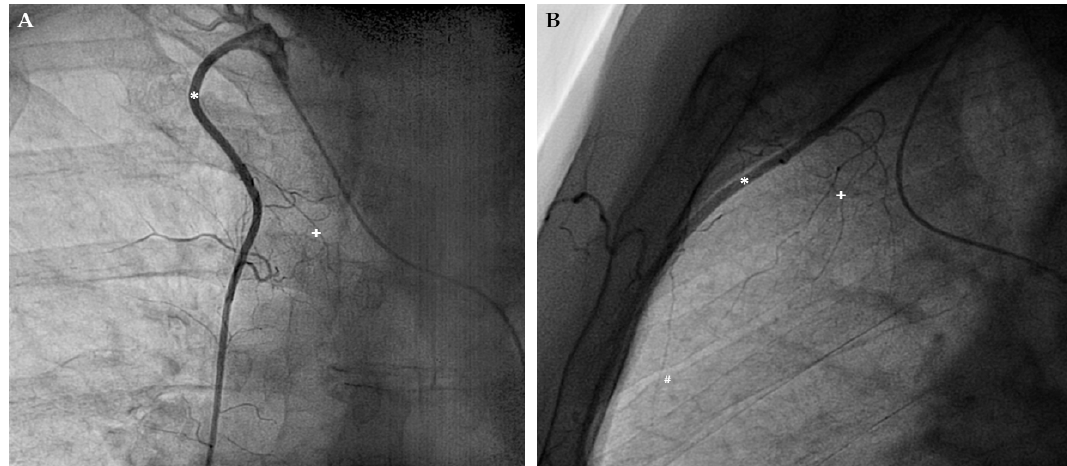
Figure 1. Angiographic demonstration of extracardiac coronary supply. ( A ) Posterior-anterior projection of the right internal mammary artery (IMA, marked by *) and its connection to the right coronary artery via the pericardiacophrenic branch (marked by +). ( B ) Lateral projection using the same markers. Noteworthy, additional branches of the IMA (marked by #) heading towards the heart.